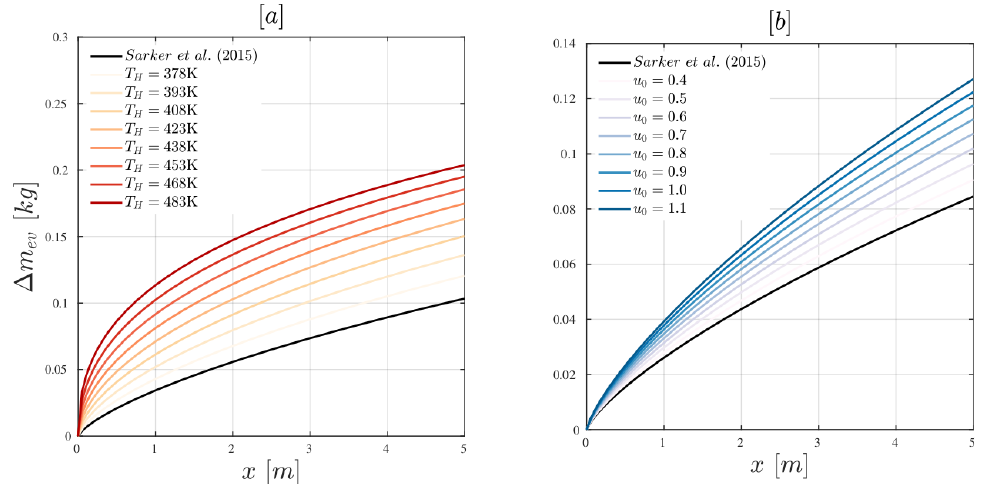
Figure 2. Cumulative evaporated water along the bed length at different drying air inlet temperature ( a ) and moisture content ( b ) of the product